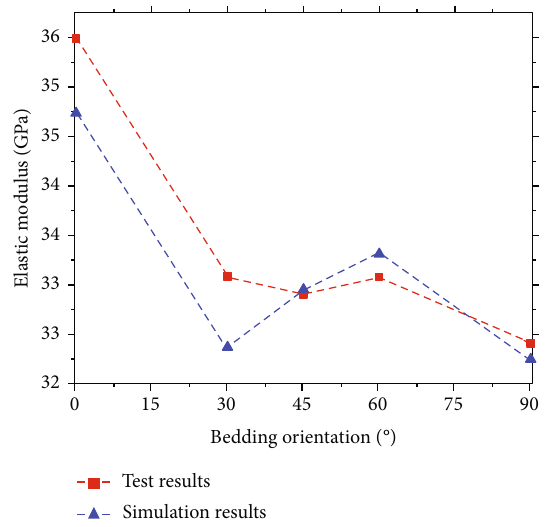
Figure 17: The contrast between simulation and test results on the variation of elastic modulus over β .